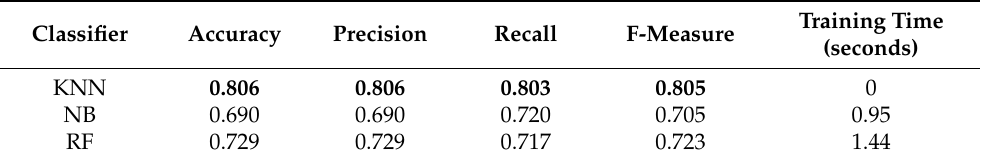
Table 7. Identification results of VGG-19-deep features obtained by averaging (F6 and F7). Bold values signify the best performance.